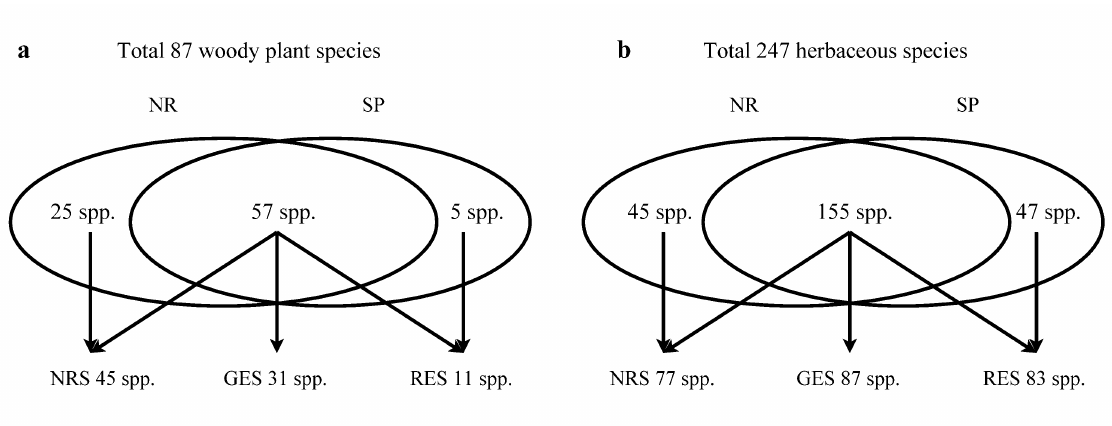
Figure 3. Species richness of totality and frequency tendency distribution species groups occurring under the naturally regenerated forests (NR) and the reforested spruce forest (SP) originating from similar clear-cuts in the eastern Tibetan Plateau. ( a ) woody plant species classification; and ( b ) herbaceous species classification. Frequency tendency distribution: natural regeneration species group (NRS), species only present or more frequent in naturally regenerated forests relative to reforested spruce plantations; reforestations species group (RES), species only or more frequent in reforested spruce plantations species relative to natural stands; generalist species group (GES), common in both forests, and with no significant difference in frequency between the two forests. The difference of frequency for each species between the NR and the SP was tested by generalized linear mixed-effects models (GLMMs). Treatment (NR vs. SP) was introduced as a fixed factor and stands (12 vs. 12) as a random factor, with three plots nested in each stand, and nine quadrats nested in each plot. In common species, a binomial error distribution with logit-ling function for presence (1) and absence (0) of each species in each quadrat was selected in